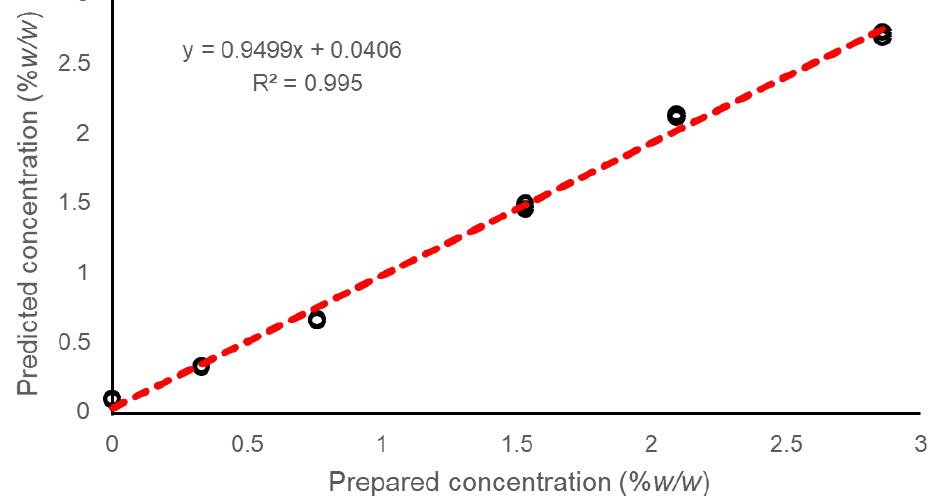
Figure 9. Absolute quantification of PHE in PVA-GS films. Prepared concentration % w / w regressed against predicted concentration % w / w .